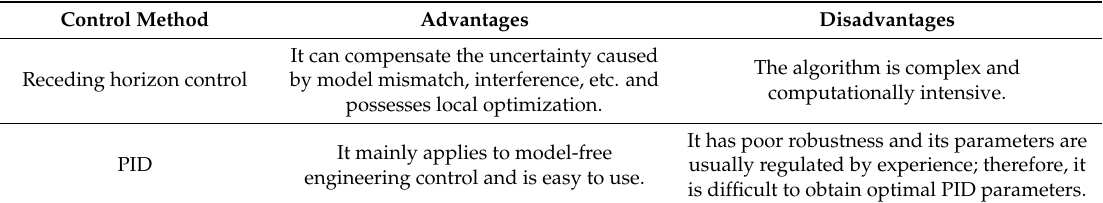
Table 2. Advantages and disadvantages of control